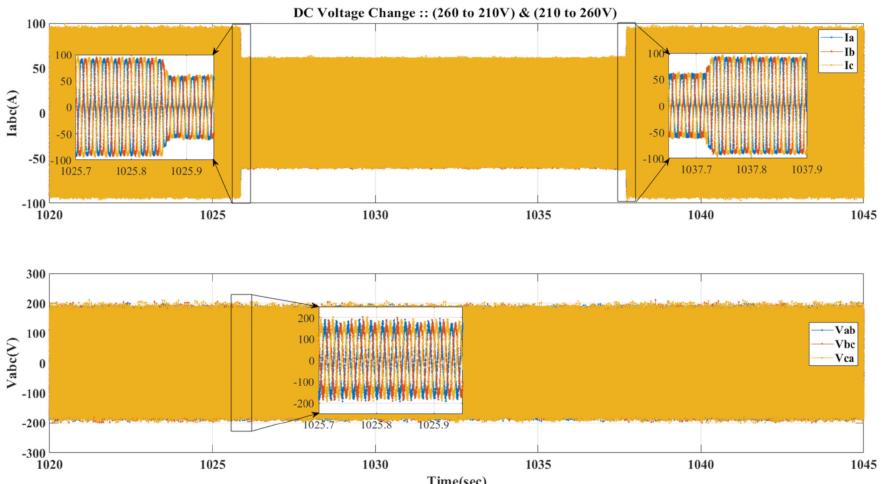
Figure 18. Test 1: Three–phase AC voltages and currents.